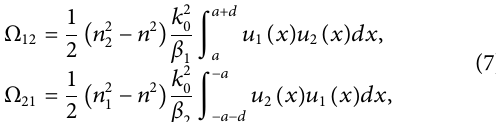
( Figure 2B ), the dielectric strip serves as the core of a three- layered dielectric planar waveguide ( Figure 2C ). The refractive index of the core is independent of the width of the dielectric strip and is equal to the effective mode index of the TM mode in the planar graphene sheet sandwiched between the substrate and dielectric strip, which is written as [35]